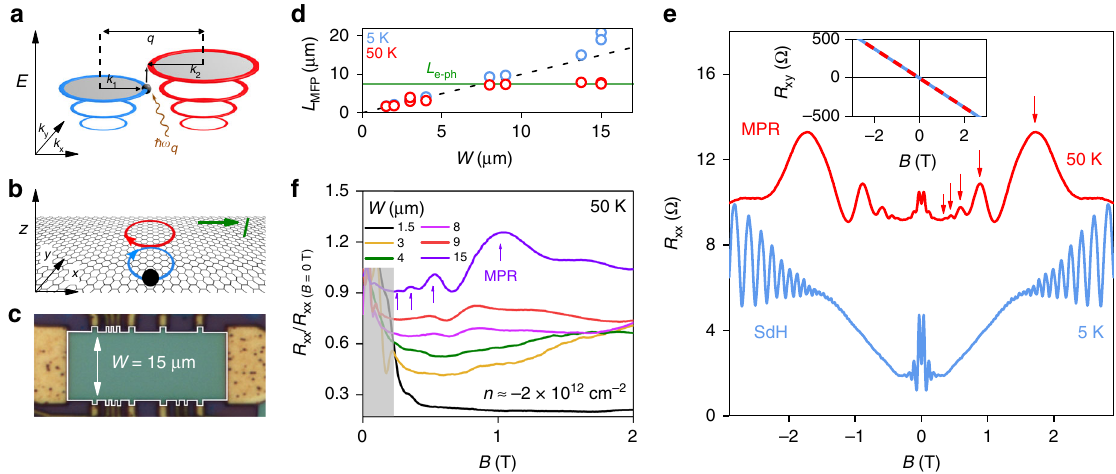
Fig. 1 Size-dependent magnetoresistance oscillations in mesoscopic graphene devices. a Landau level spectra of graphene. The diagram illustrates a carrier with momentum k 1 (black sphere) making a transition between Landau levels (blue and red rings) by resonant absorption of a phonon (brown arrow) with momentum q = | k 1 − k 2 | and energy ħ ω q . Solid black arrows represent the magnitudes of wave vectors k 1 , k 2 and q . b The semiclassical motion of a carrier (black sphere) in real space for the resonance condition sketched in a . The red and blue circles which touch at a tangent point represent the initial and fi nal semiclassical cyclotron orbits of two Landau-quantised states between which an electron is scattered by a phonon. During resonant scattering, the carriers follow a path that resembles the number 8 ( fi gure of eight trajectory). The red and blue arrows show the motion of the charge carriers along this trajectory. The green arrow indicates direction of the applied current I . c Optical image of a graphene device with W = 15 μ m. The edges of the mesa are indicated by the white solid line. d Open circles plot experimentally determined Drude mean free path L MFP as a function of W for two T and fi xed n = − 2 × 10 12 cm − 2 . Black dashed line plots the equation L MFP = W . Solid green line marks the phonon-limited mean free path ( L e – ph ) at 50 K. Our measurements focussed on the valence band because our wide devices exhibited higher electronic quality for hole doping ( e ), longitudinal magnetoresistance data R xx ( B ) for fi xed n = − 3.3 × 10 12 cm − 2 measured in our wide device ( c ) at two different T . The red arrows indicate peaks that are caused by magnetophonon resonance (MPR). The 50 K curve is off-set vertically for clarity. Inset: Hall resistance R xy ( B ) measured simultaneously as R xx . The solid blue and dashed red lines are data measured at 5 and 50 K respectively. f R xx / R xx ( B = 0T) measured at fi xed n and T in several devices of different W . The shaded area close to B = 0